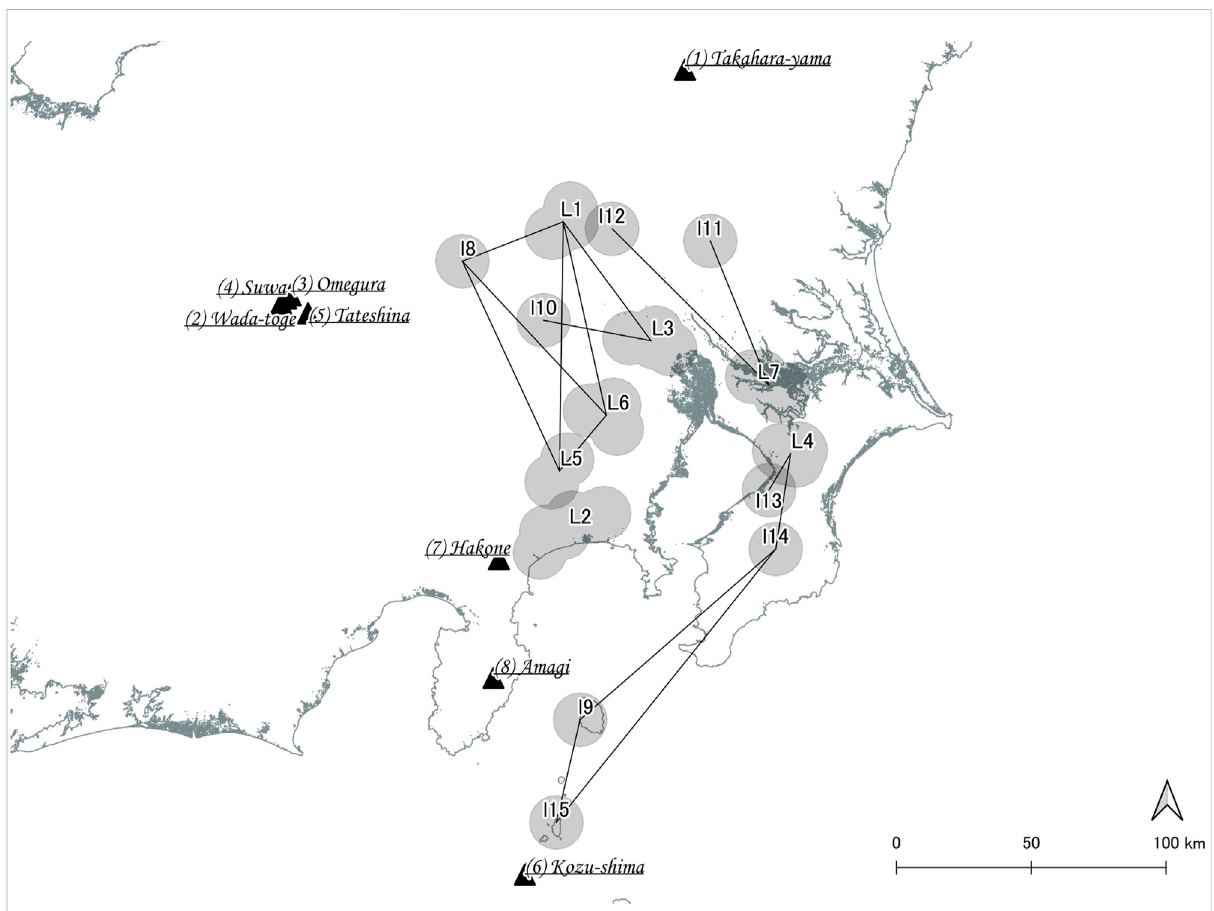
FIGURE 11 Network among consumption areas in Period 4, the late Jomon period (4,500 – 3,200 years cal BP). Clusters are represented by uppercase characters and single sites by lowercase characters. Pairs with a cosine similarity of more than 0.9 in the composition ratio of each provenance area are